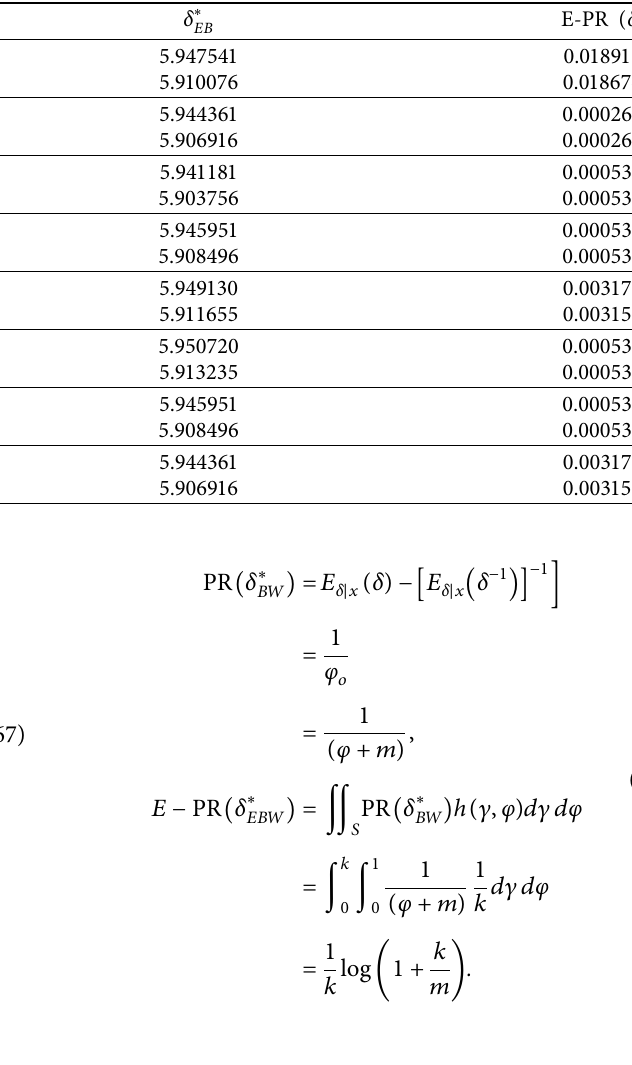
Figure 2: Density, Q-Q, CDF, and P-P plots of the real data. (a) Histogram and theoretical densities. (b) Q-Q plot. (c) Empirical and theoretical CDFs. (d) P-P plot. Table 11: E-B and E-PR estimates of real life